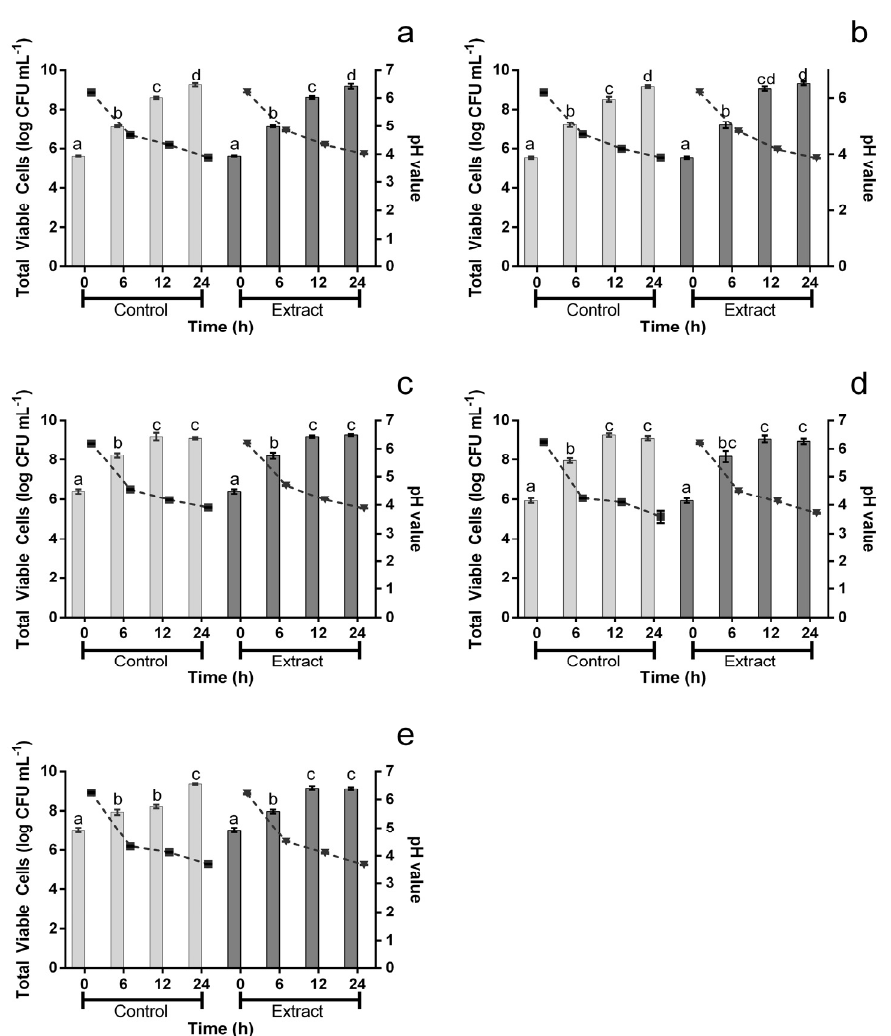
Figure 3. Total viable cells (bars) and pH values (lines) for L. rhmamnosus ( a ), L. plantarum ( b ), L. acidophilus ( c ), B. Bo ( d ) and B. Bb12 ( e ) when exposed, or not, to 1000 μ g mL − 1 of the extract. Different letters mark the statistically significant ( p < 0.05) differences between the bars.